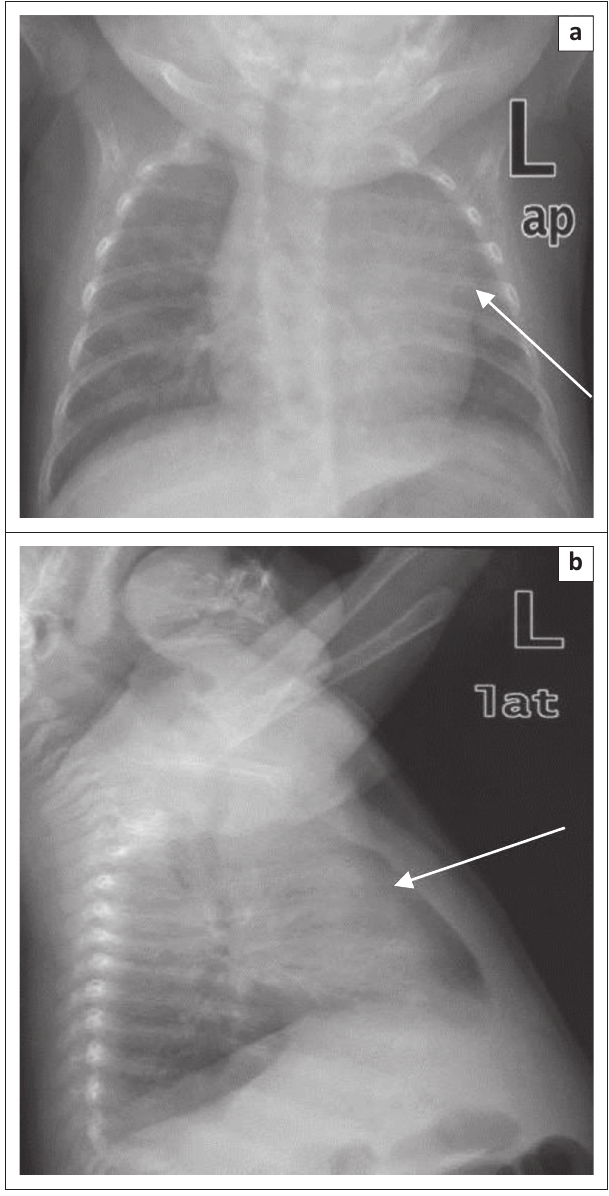
FIGURE 2: Frontal chest radiograph (a) showing apparent cardiomegaly as a result of thymus (arrow) density overlying the left heart border. A lateral view (b) identifies the opacity as a thymus (arrow) in the anterior mediastinum separate from the cardiac